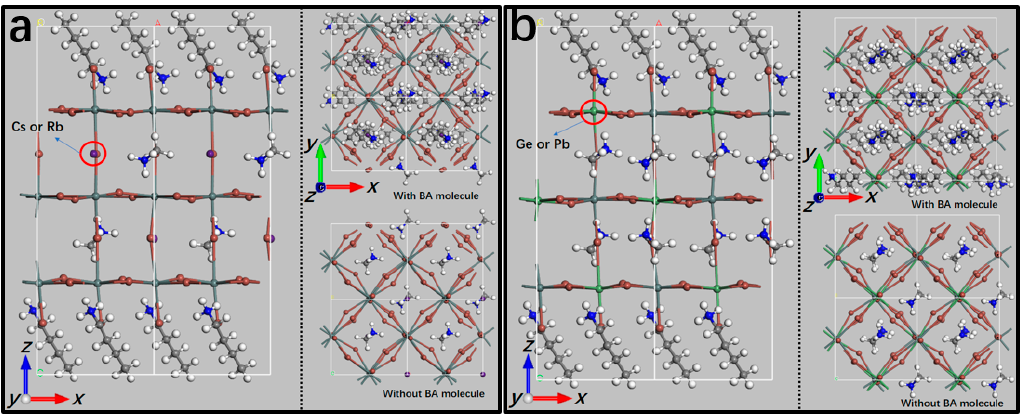
Figure 1. ( a ) Optimized structures of BA 2 MA 2 B 3 X 10 (B = Pb 2+ or Sn 2+ ; X = Br − or I − ) with the mixed Cs/Rb atoms. ( b ) Relaxed structures of BA 2 MA 2 Sn 3 I 10 with the mixed Ge/Pb atoms. Sn/Pb = silver gray; Cs/Rb Cs / Rb atoms. ( b ) Relaxed structures of BA 2 MA 2 Sn 3 I 10 with the mixed Ge / Pb atoms. Sn / Pb = silver = purple; Ge/Pb = green; I/Br = bronze; N = blue; C = gray; H = white. gray; Cs / Rb = purple; Ge / Pb = green; I / Br = bronze; N = blue; C = gray; H =